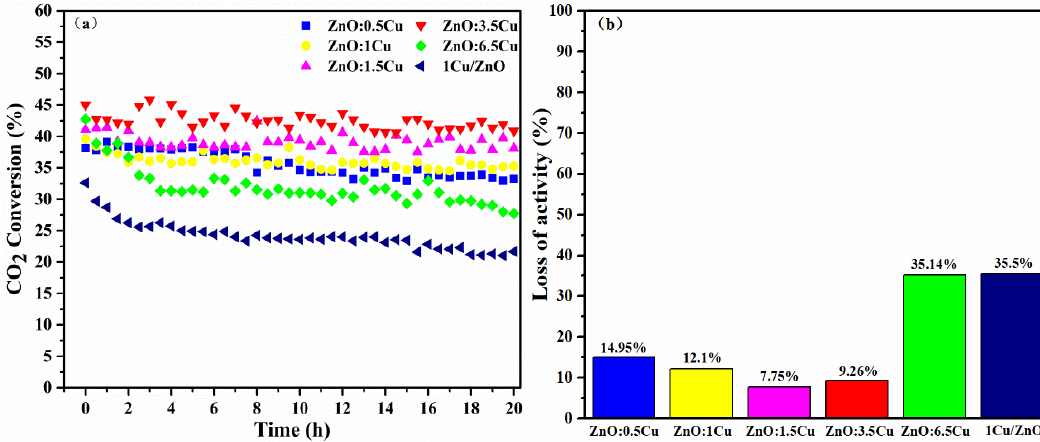
Figure 9. Stability test of Cu-ZnO model catalysts for the RWGS reaction at 600 °C ( a ) and catalytic activity loss percentage after reaction for 20 h ( b ).